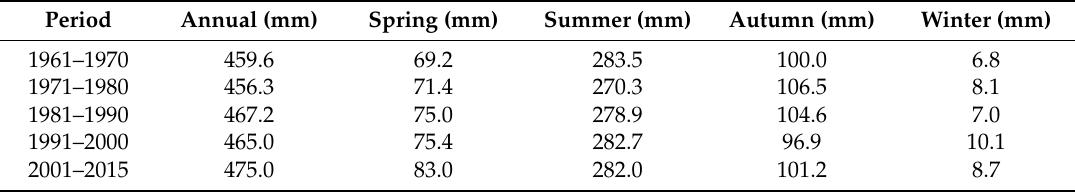
Table 3. The average annual and seasonal precipitation in different periods during 1961–2015.